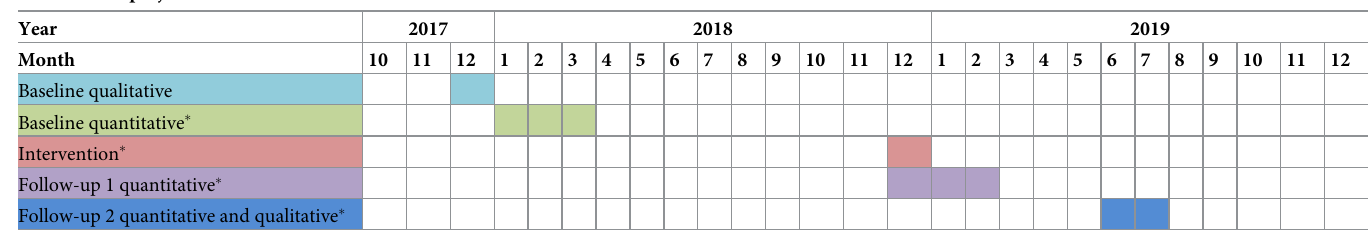
Table 1. The project